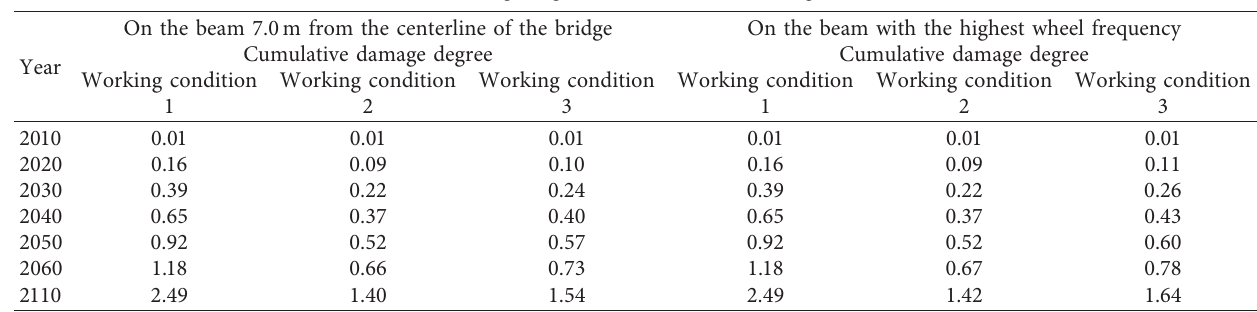
Table 10: Damage degrees under various working conditions.